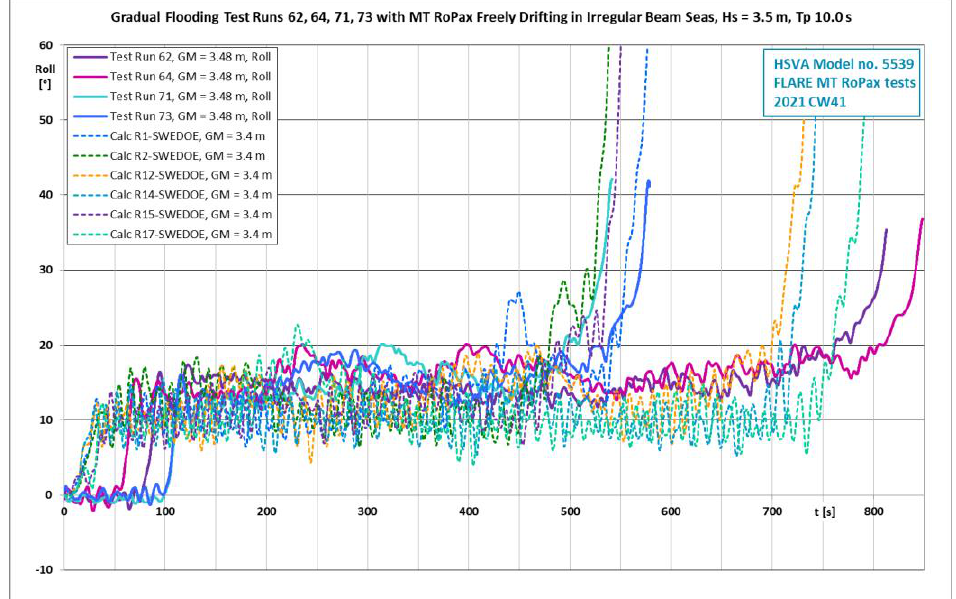
Figure 9. Computed and experimental time histories of the roll angle of the ship in irregular beam seas with H S 3.5 m and T P 10.0 s, shown until capsize. The computed curves show the results obtained using the boundary condition SWEDOE.